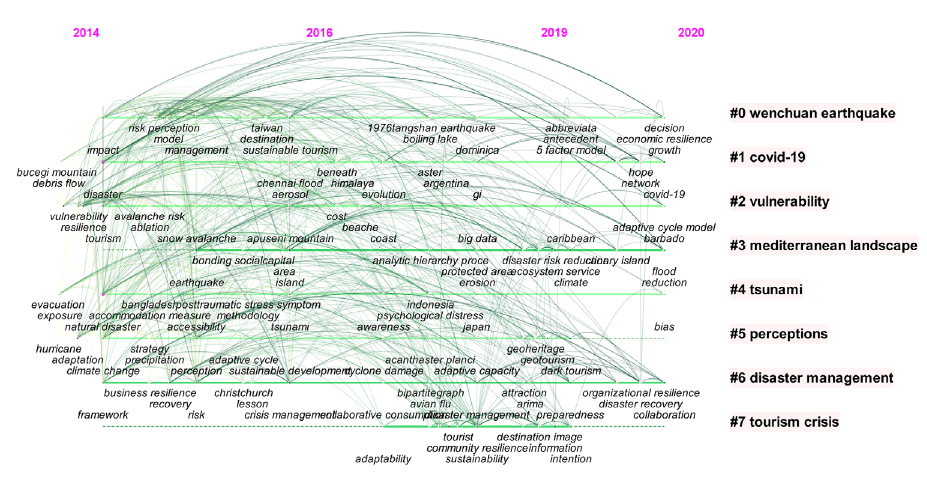
Figure 8. A timeline view of keywords in different clusters from 2014 to